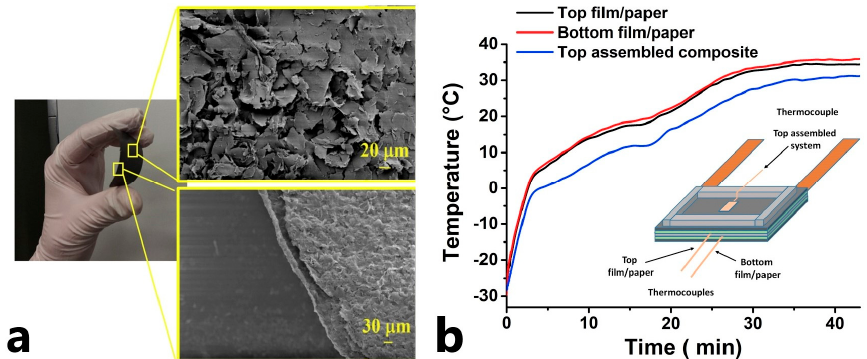
Figure 8. ( a ) SEM images of the graphene paper, ( b ) the temperature pro fi le during the de-icing process, at an environmental temperature of − 32 °C (Reprinted from Elsevier, copyright 2019) [63].